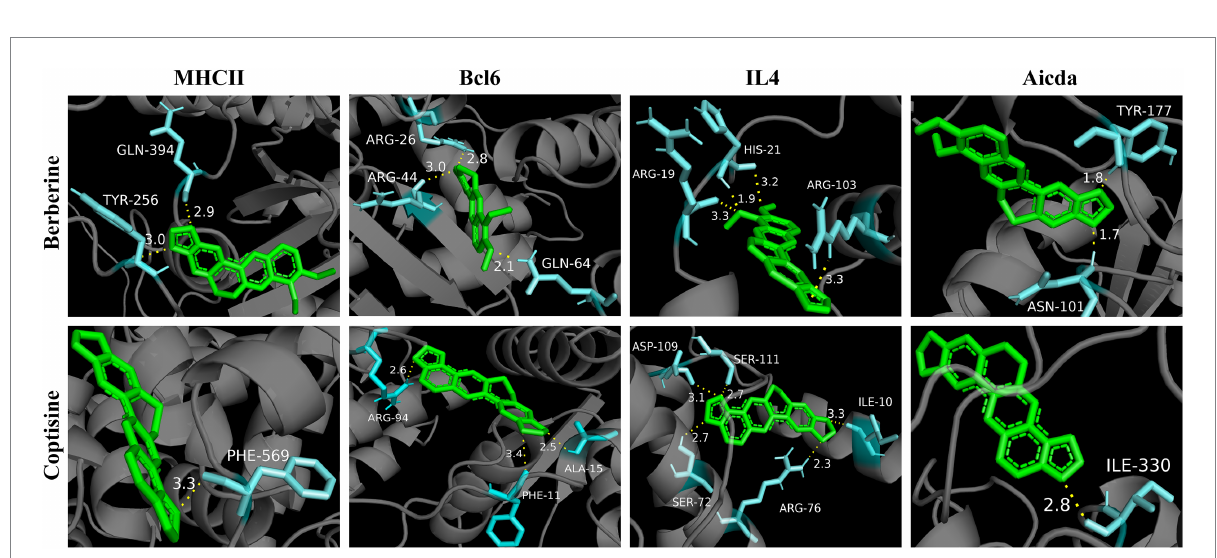
FIGURE 7 Molecular docking diagram of berberine and coptisine in YJP-A and the key proteins (MHC II, Bcl6, IL-4,